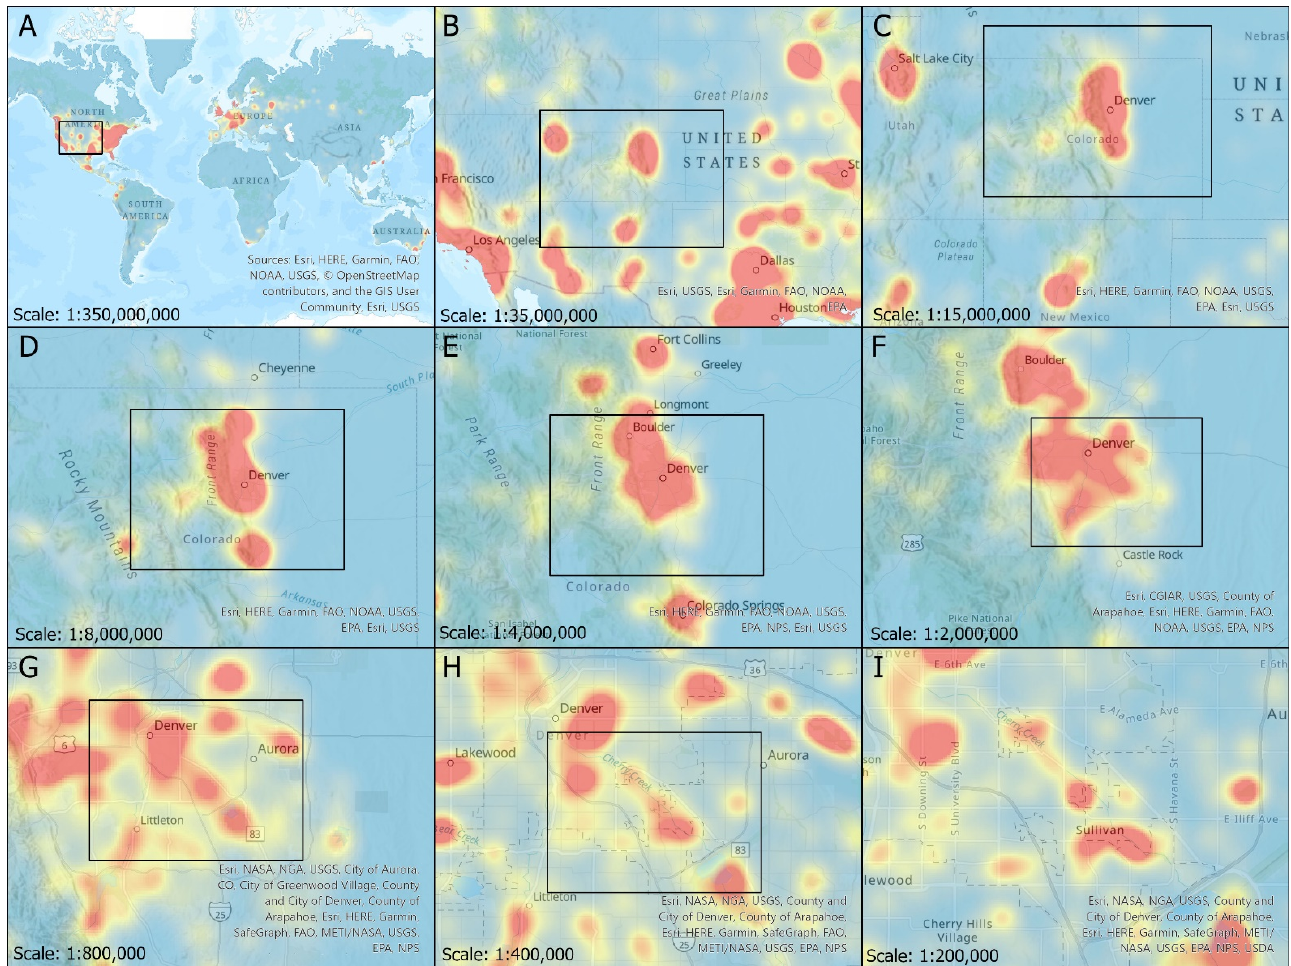
Figure 2. iNaturalist observation hot-spots (2020) in the Denver metropolitan area across spatial scales. ( A – I ) corresponds to the increasingly large map scales at which hot-spots are detected and visualized. On each map, red color represents high observation density, and the inner box indicates the display extent of the next map in sequence rendering finer-scale hot-spots.